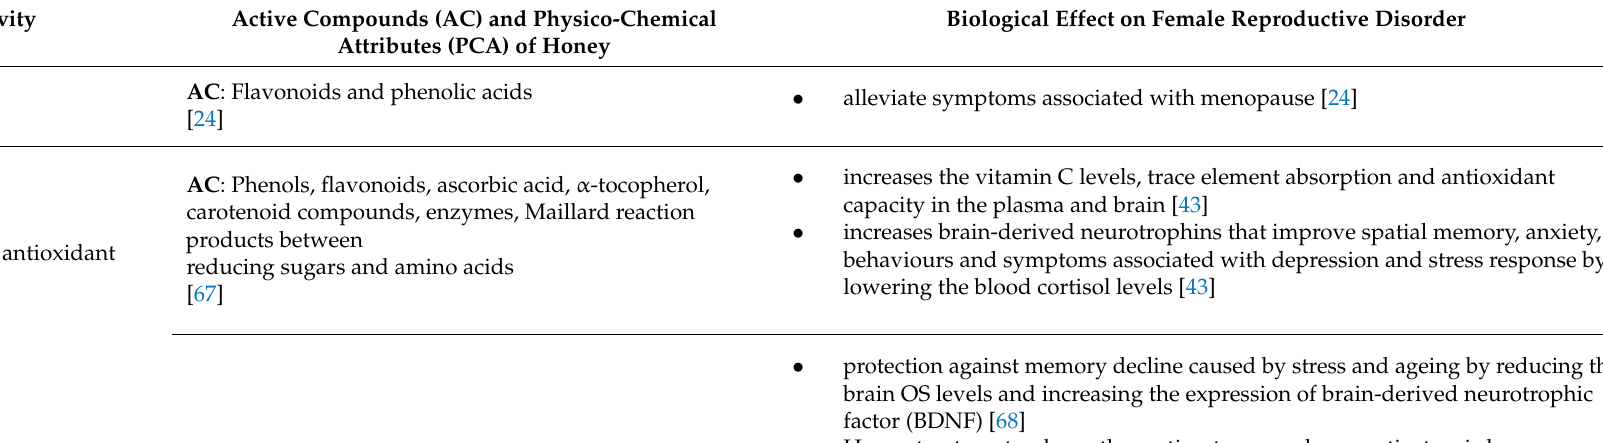
Table 4. Summary of active compounds and physico-chemical attributes of honey with oestrogenic, anti-inflammatory, antioxidative and anti-fungal